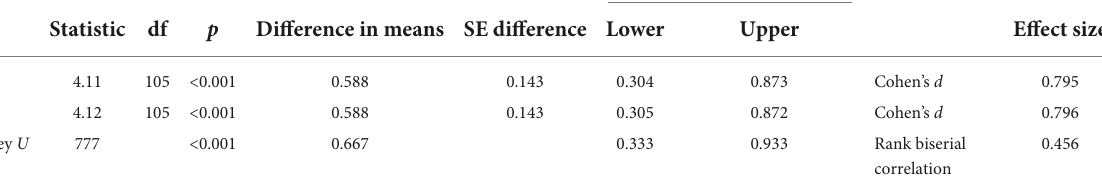
TABLE 6 Independent samples t -test for 1st grade groups using general music sophistication as a dependent variable.